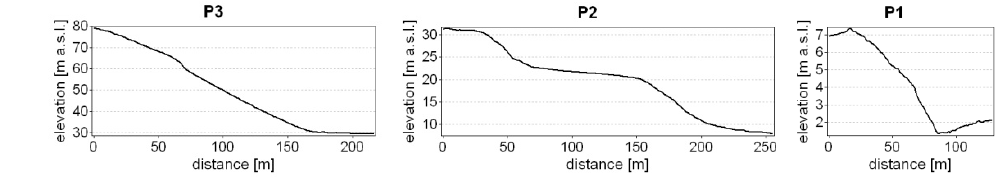
Figure 10. Forefield of the Baranowski Glacier in 2016 (southern tongue) (Photo J. Sziło).